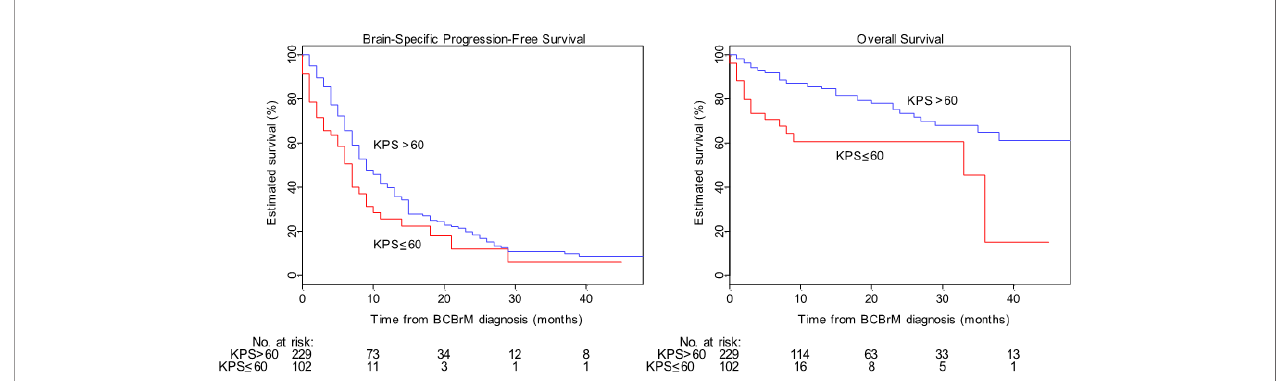
FIGURE 1 | Brain-speci fi c progression-free survival ( “ bsPFS ” ) and overall survival ( “ OS ” ) by Karnofsky Performance Status ( “ KPS ” ) cohort. Survival plots are shown of the low-KPS (red) and high-KPS (blue) cohorts for bsPFS (left) and OS (right). Low KPS is statistically signi fi cantly associated with both shorter bsPFS and shorter OS in